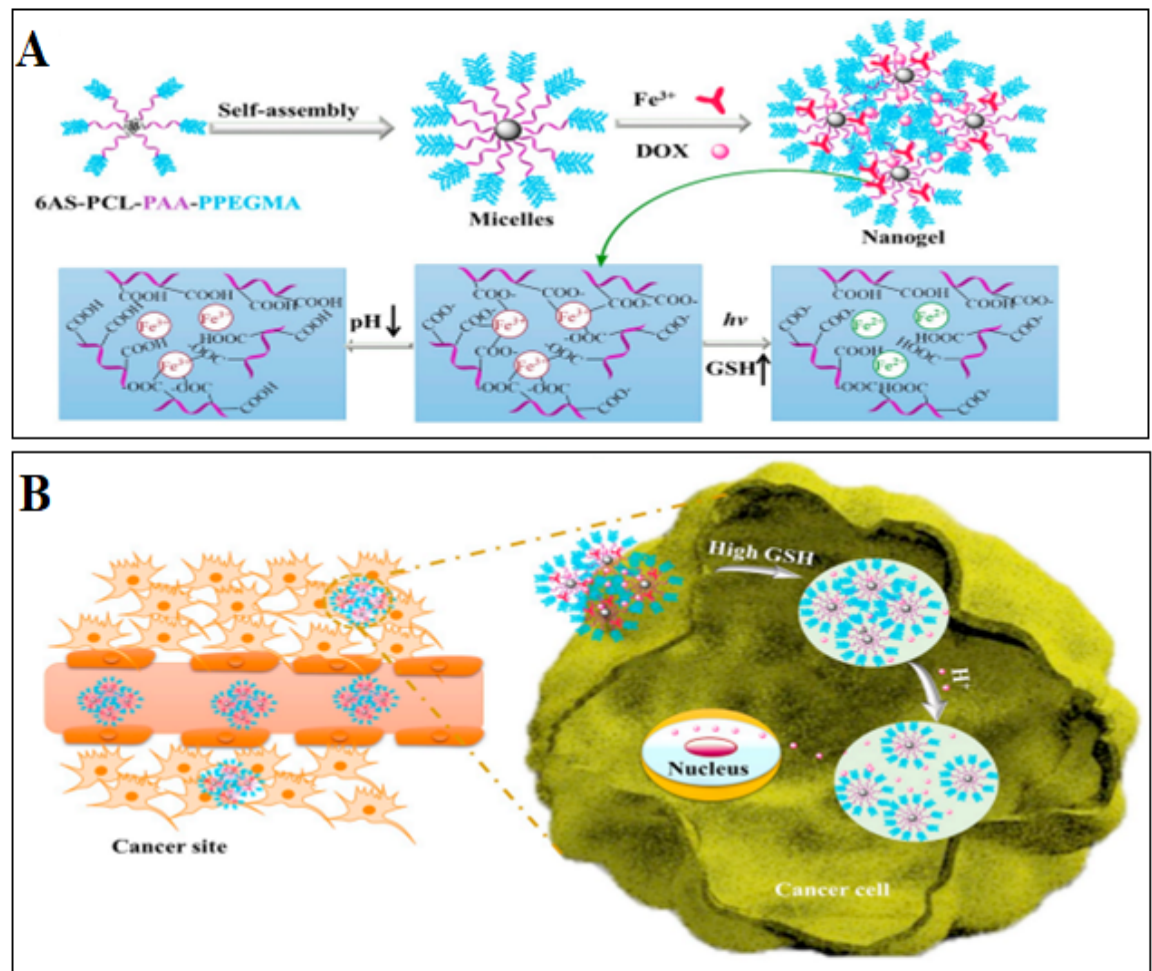
Figure 10. ( A ) Schematic representation of micelle formation, gelation with Fe 3+ and pH-, UV- and GSH-triggered drug release mechanism. ( B ) Intracellular release of multi-responsive nanogels encapsulated with anticancer drugs.